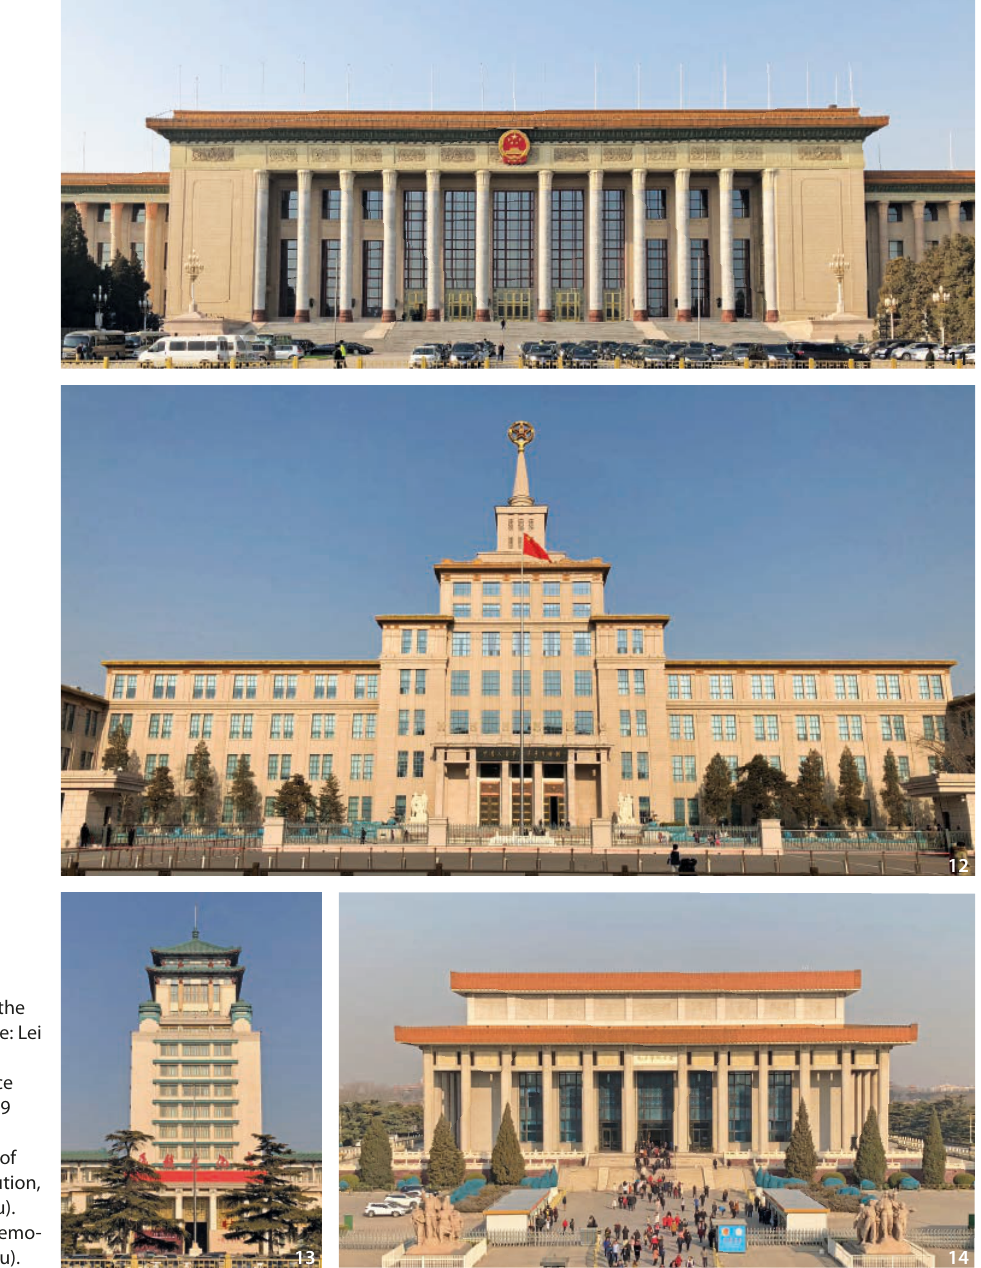
Figure 11 The Great Hall of the People, Beijing, 1959 (Source: Lei Liu). Figure 12 The Cultural Palace of Nationalities, Beijing, 1959 (Source: Lei Liu). Figure 13 Military Museum of the Chinese People's Revolution, Beijing, 1959 (Source: Lei Liu). Figure 14 Chairman Mao Memo- rial Hall, 1977 (Source: Lei